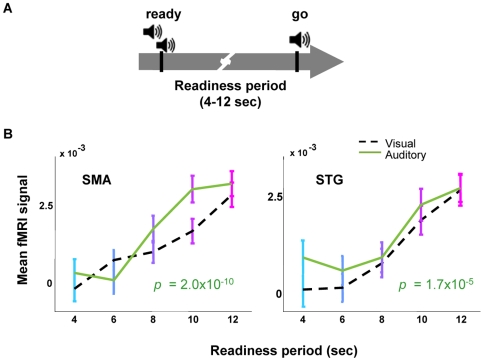
Evidence for an expectation-dependent fMRI signal generalizes to an auditory ready-go experiment.(A) Participants viewed a blank screen. A brief double beep served as the ready signal, and a brief single beep served as the go signal. (B) As in the visual condition (Figure 1), longer readiness periods correlate with higher post-go fMRI signal (p-values of the correlation inset). Solid line, data from the auditory experiment. For comparison, the dashed line shows the fMRI results from the visual experiment (Figure 1). Error bars SEM.